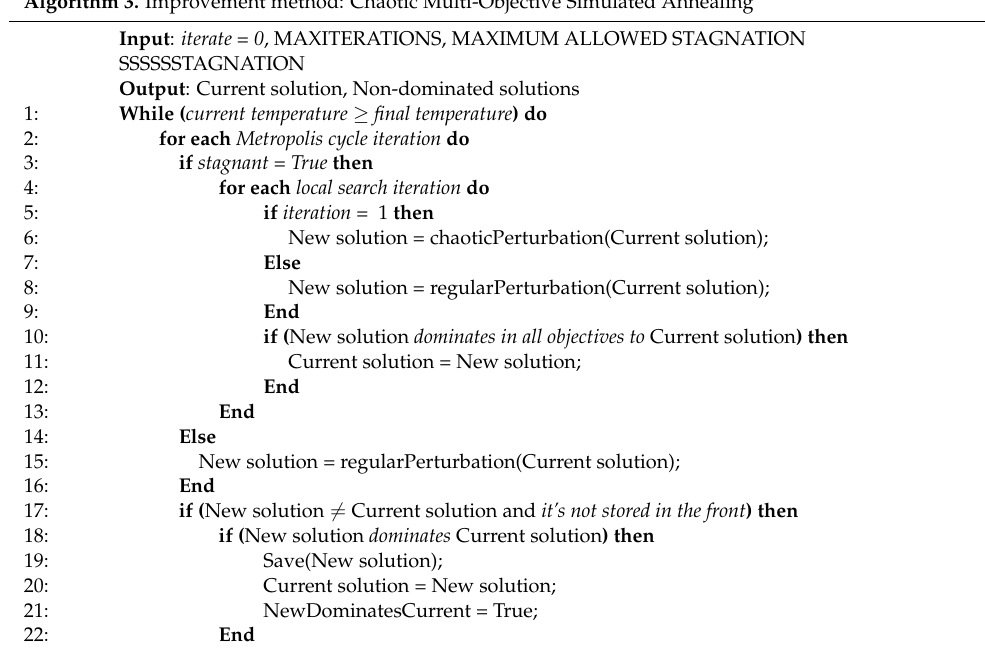
Algorithm 3. Improvement method: Chaotic Multi-Objective Simulated